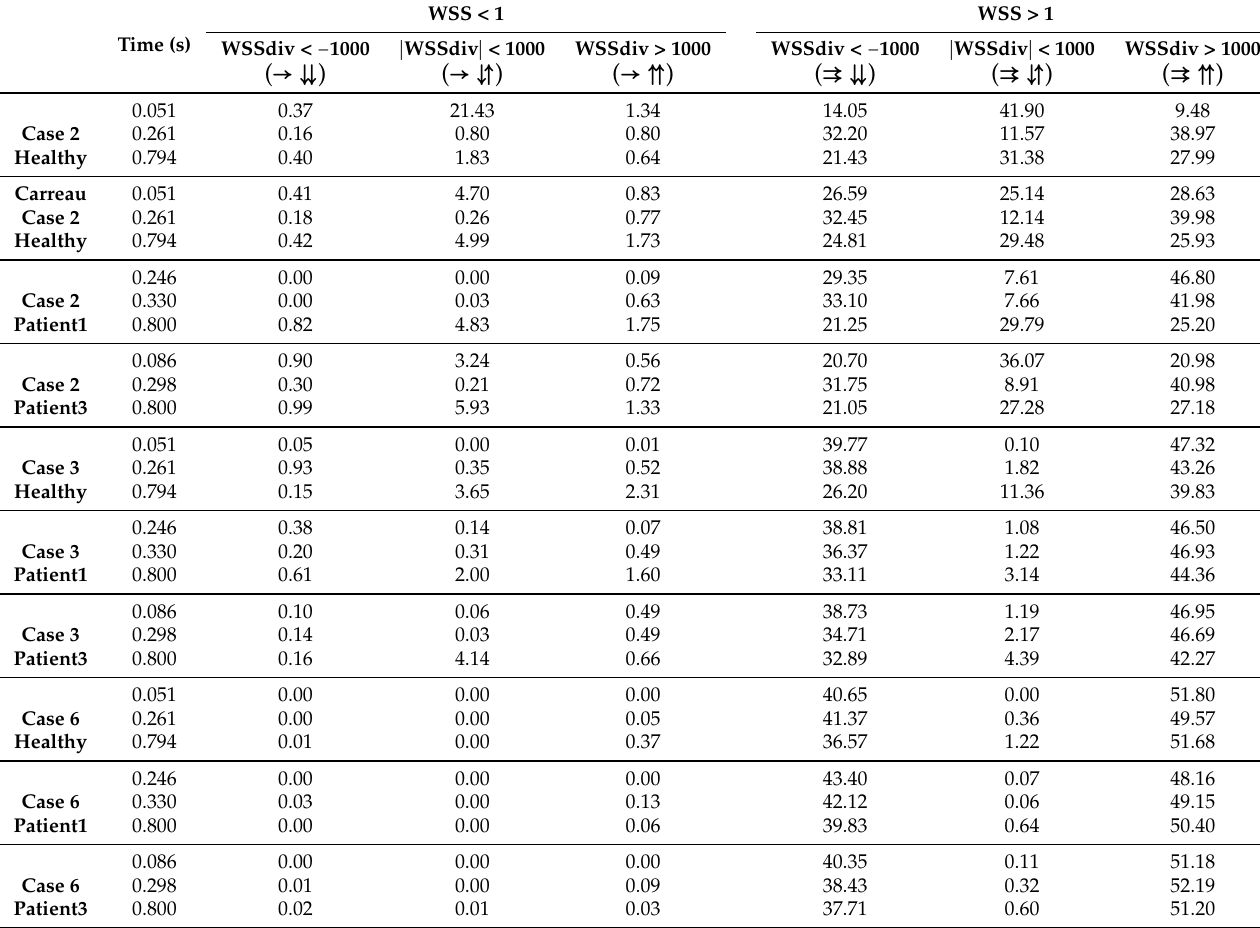
Table A2. Continuation of Table 3, for Case 2, Case 3 and Case 6 with flow rate profiles shown in Figure